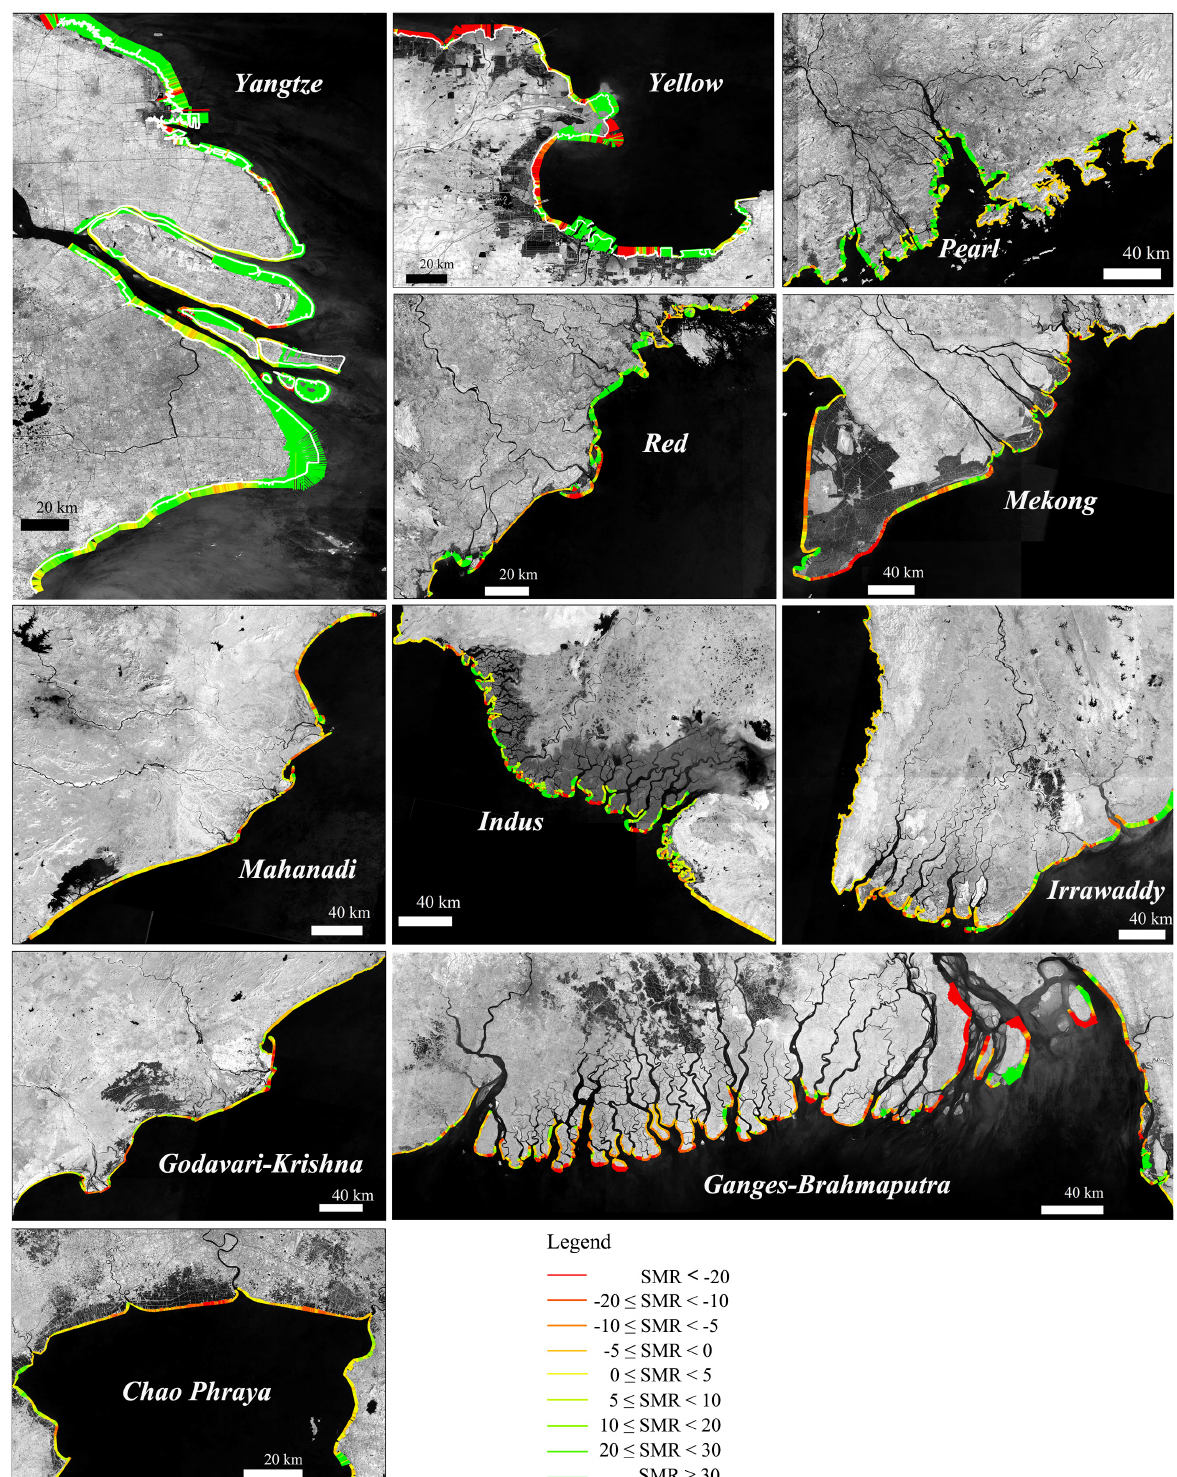
Figure 4. Shoreline migrations of Asian deltas from 1986 to 2018. SMR: Shoreline Migration